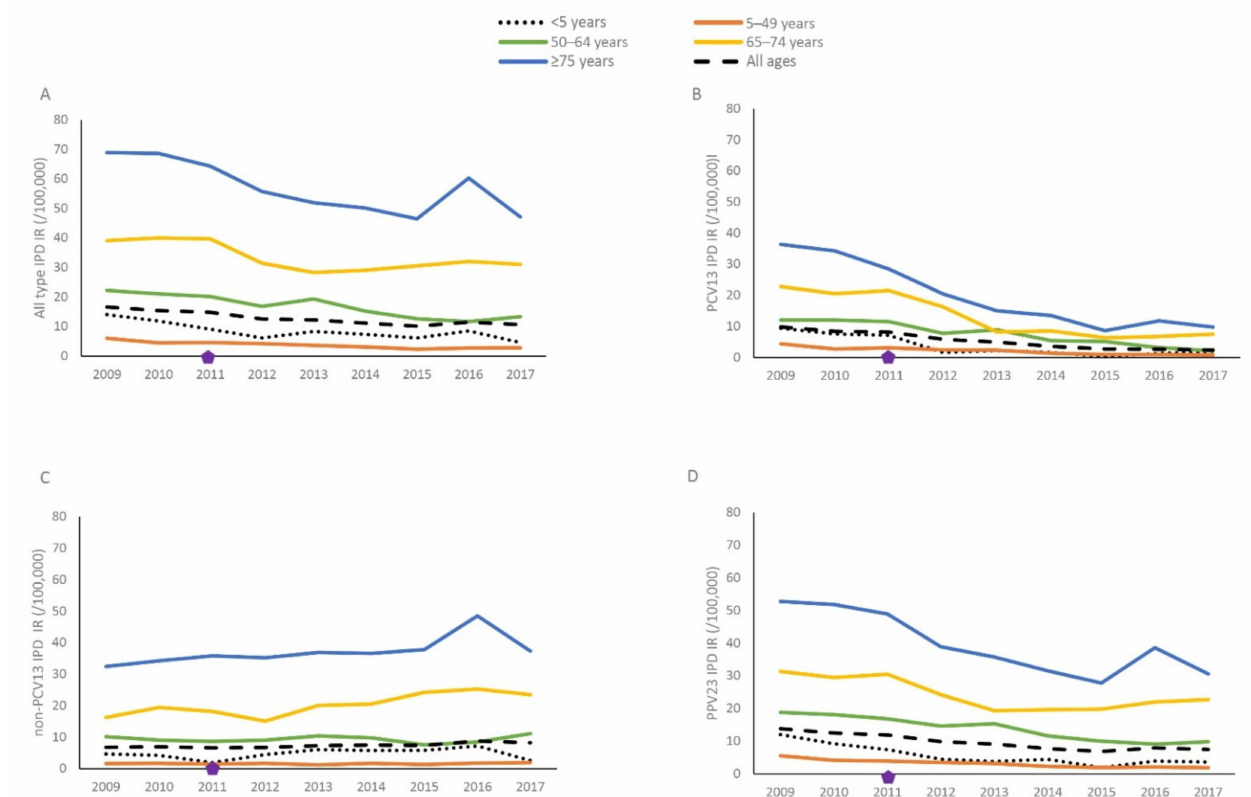
Figure 1. IPD incidence rate by age group in Norway 2009 to 2017. ( A ) All types of IPD, ( B ) PCV13 IPD, ( C ) non-PCV13 IPD, ( D ) PPV23 IPD, Diamonds indicate the year of PCV13 vaccine introduction (2011: PCV13). All ages and age group <5 years (stippled and dotted lines) are included as references. All types of IPD includes IPD caused by any serotype. PCV13 IPD includes serotypes 1, 3, 4, 5, 6A, 6B, 7F, 9V, 14, 18C, 19A, 19F and 23F; non-PCV13 IPD includes serotypes not included in PCV13; PPV23 IPD includes serotypes included in PCV13 except serotype 6A and serotypes 2, 8, 9N, 10A, 11A, 12F, 15B, 17F, 20, 22F and